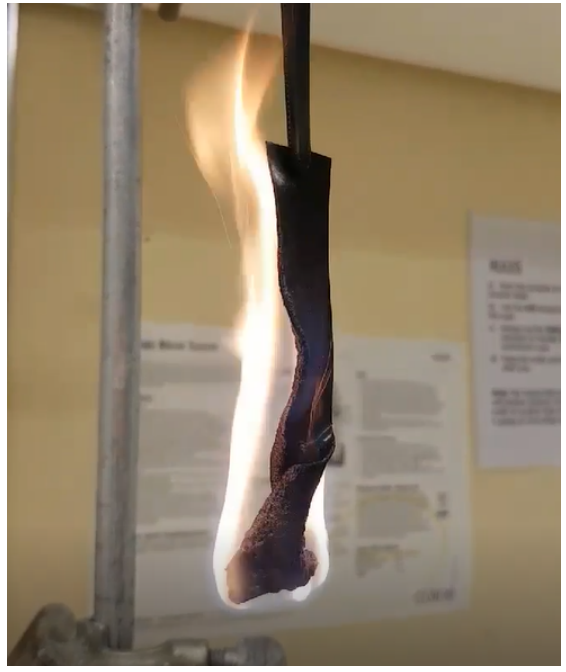
Table 6. UL- 94 test data of gluten/CB biocomposites.